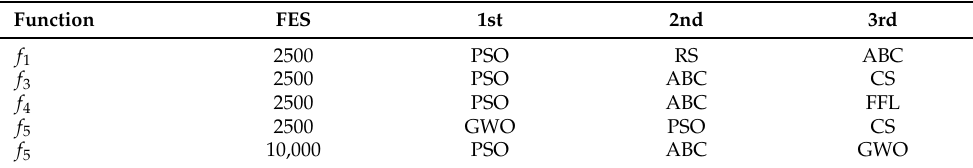
Table 9. The three best evolutionary algorithms for each testing function. Function